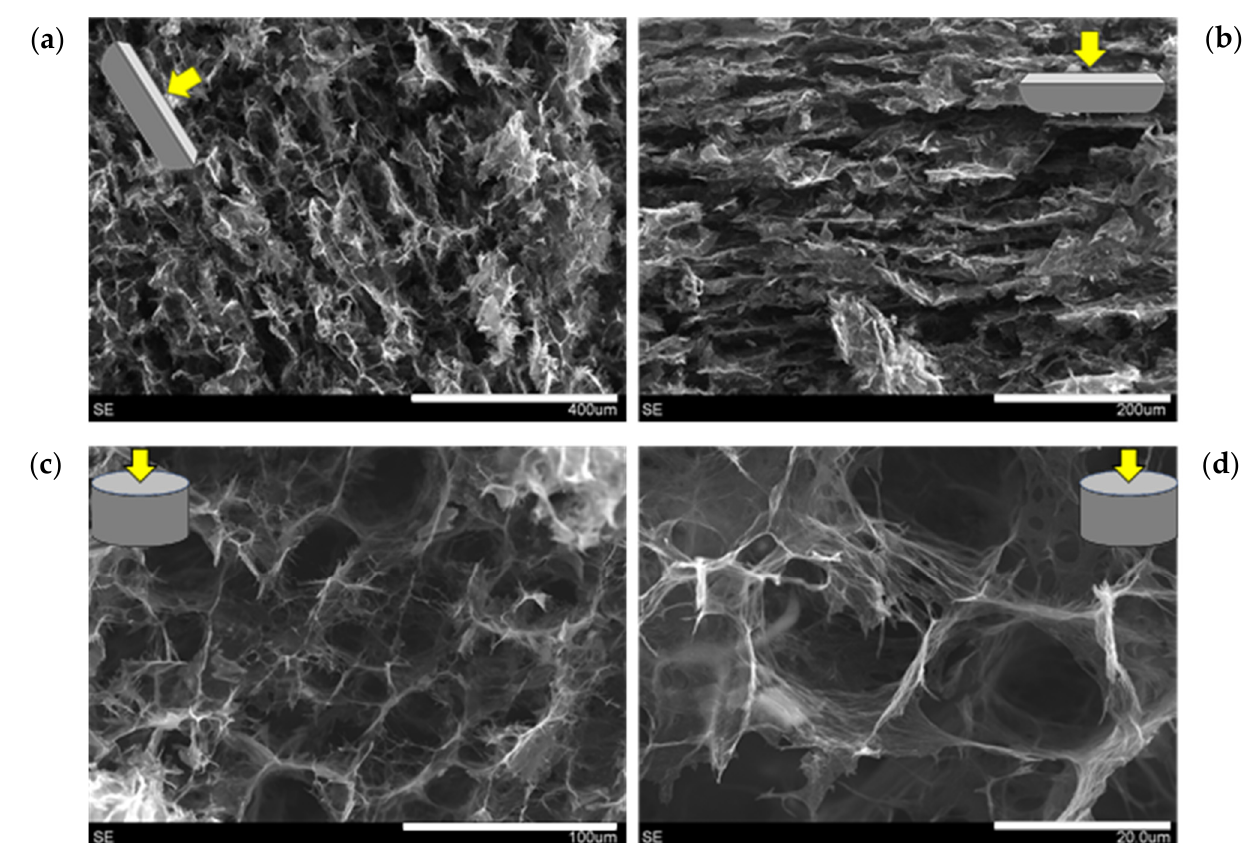
Figure 11. SEM images of aerogels derived from the unidirectional freezing followed by lyophilization of hydrothermally prepared hydrogels. Longitudinal ( a , b ) and transversal ( c , d ) cuts. Scale bars (in white): 400 μ m ( a ), 200 μ m ( b ), 100 μ m ( c ) and 20 μ m ( d ).